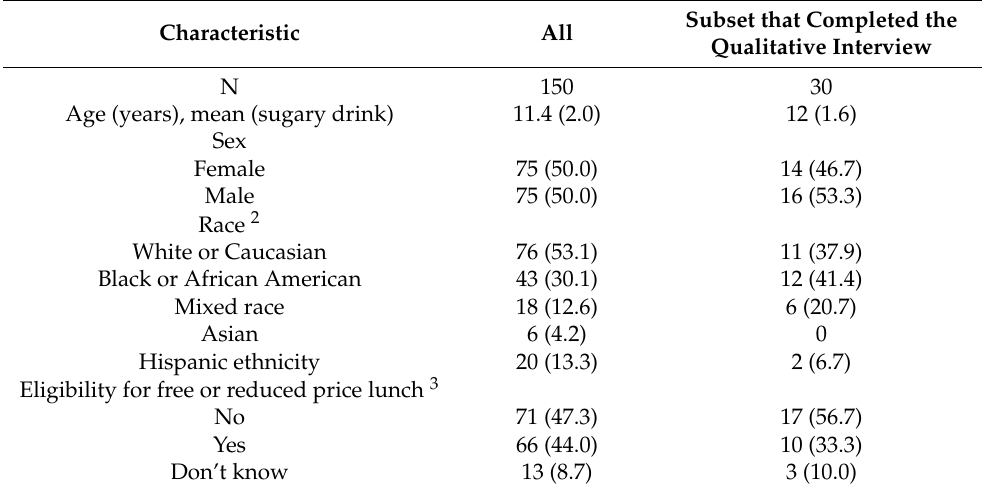
Table 1. Demographic characteristics of “Stop the Pop” participants 1 .